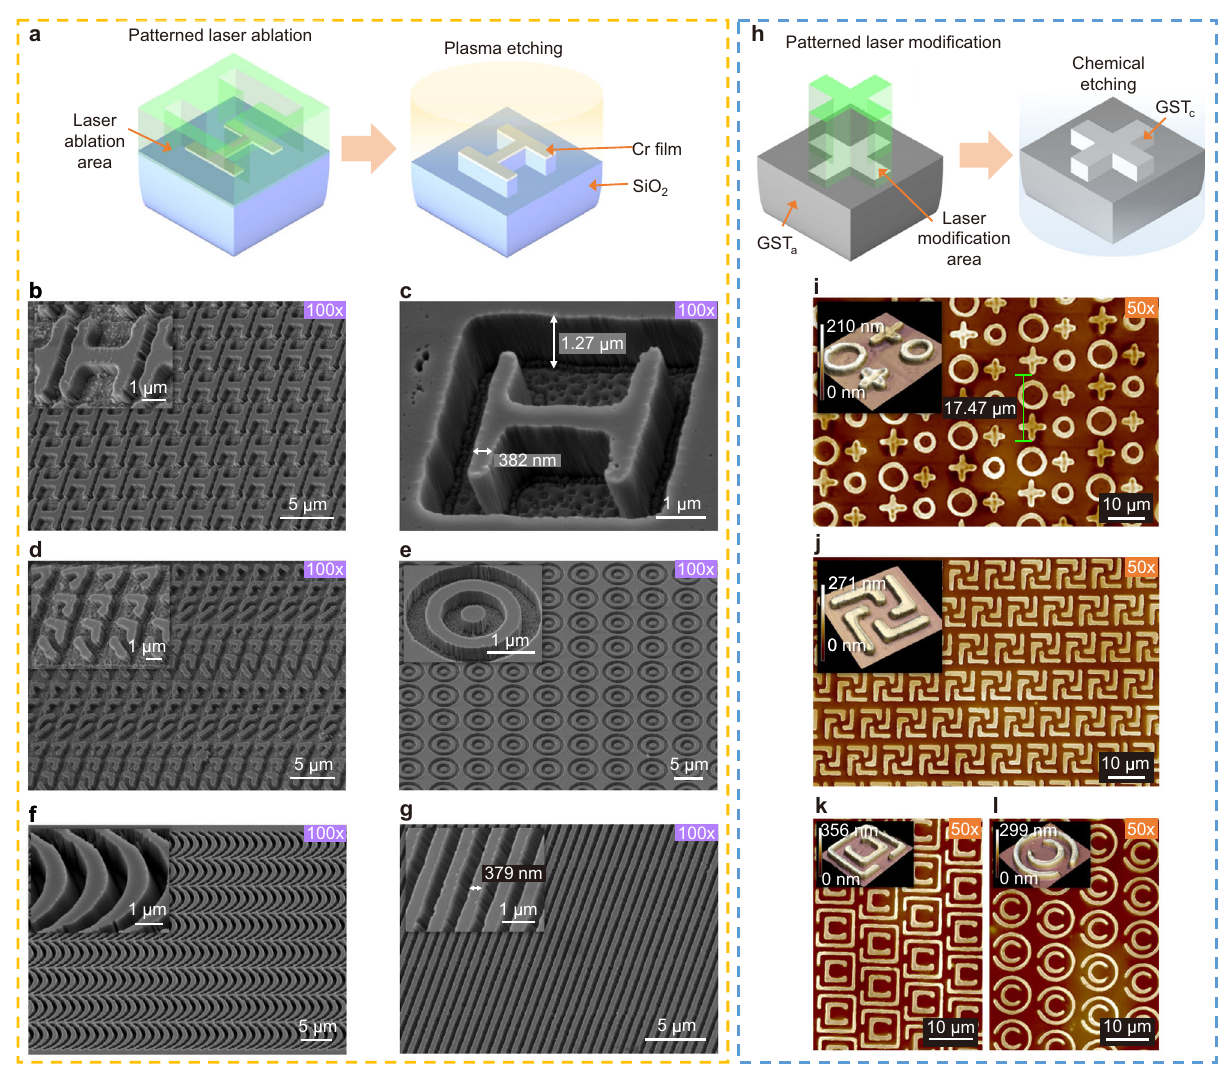
Fig.5|ClassicalpatternsformetasurfaceachievedbythePPLL.a , h Schematics offabricationprocessesofstructuresbyetchingafterPPLL. b – g SEMimagesofthe patterns after etching, including H shapes, several antennas with different orien- tations in a unit, concentric rings, catenaries, and gratings (with patterned 30nm